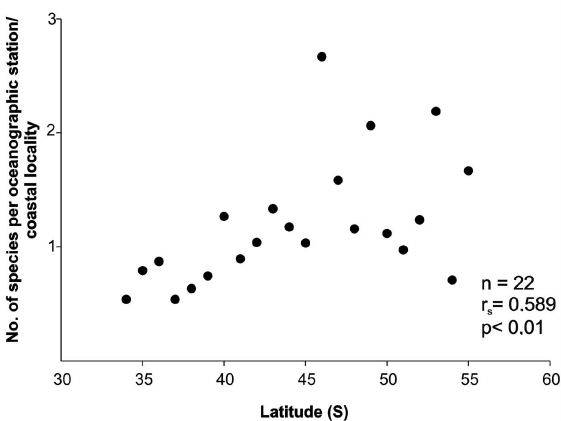
Fig. 3. – Relationship between latitude (S) and number of echino- derm species per oceanographic station/coastal locality in the study